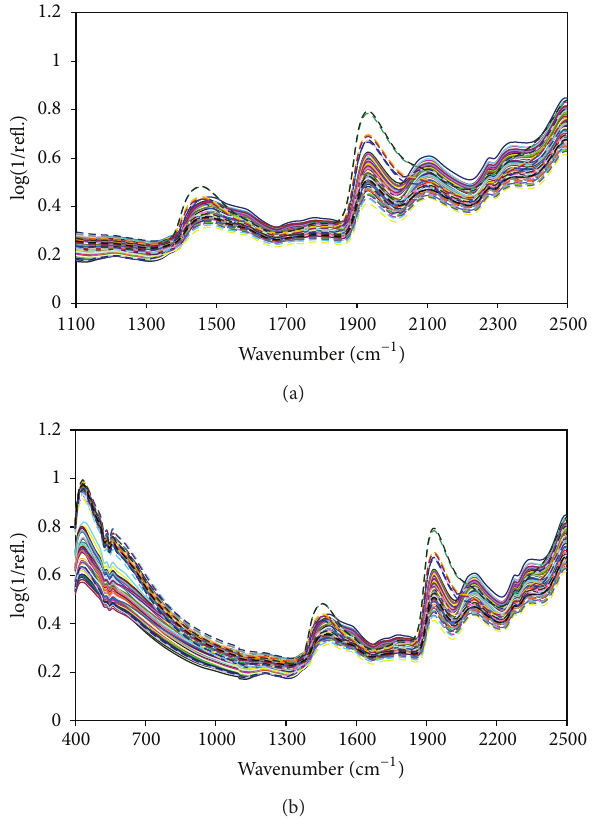
Figure 2: Near-infrared (NIR) and visible NIR (VNIR) spectra for the samples.